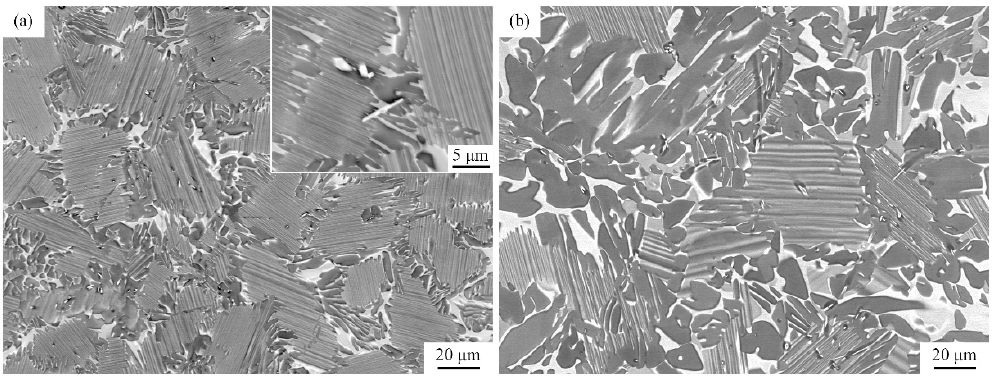
Figure 7. Microstructure of cast Ti-44Al-5Nb-1Mo-2V-0.2B alloy: ( a ) as-cast and ( b ) as-HIPed .